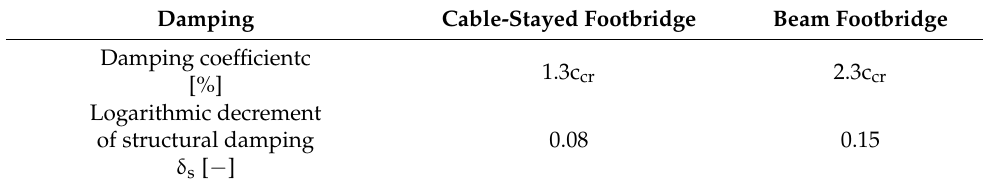
Table 9. Values of the damping Table 7. Comparison of identified frequencies of the deck’s vibrations.